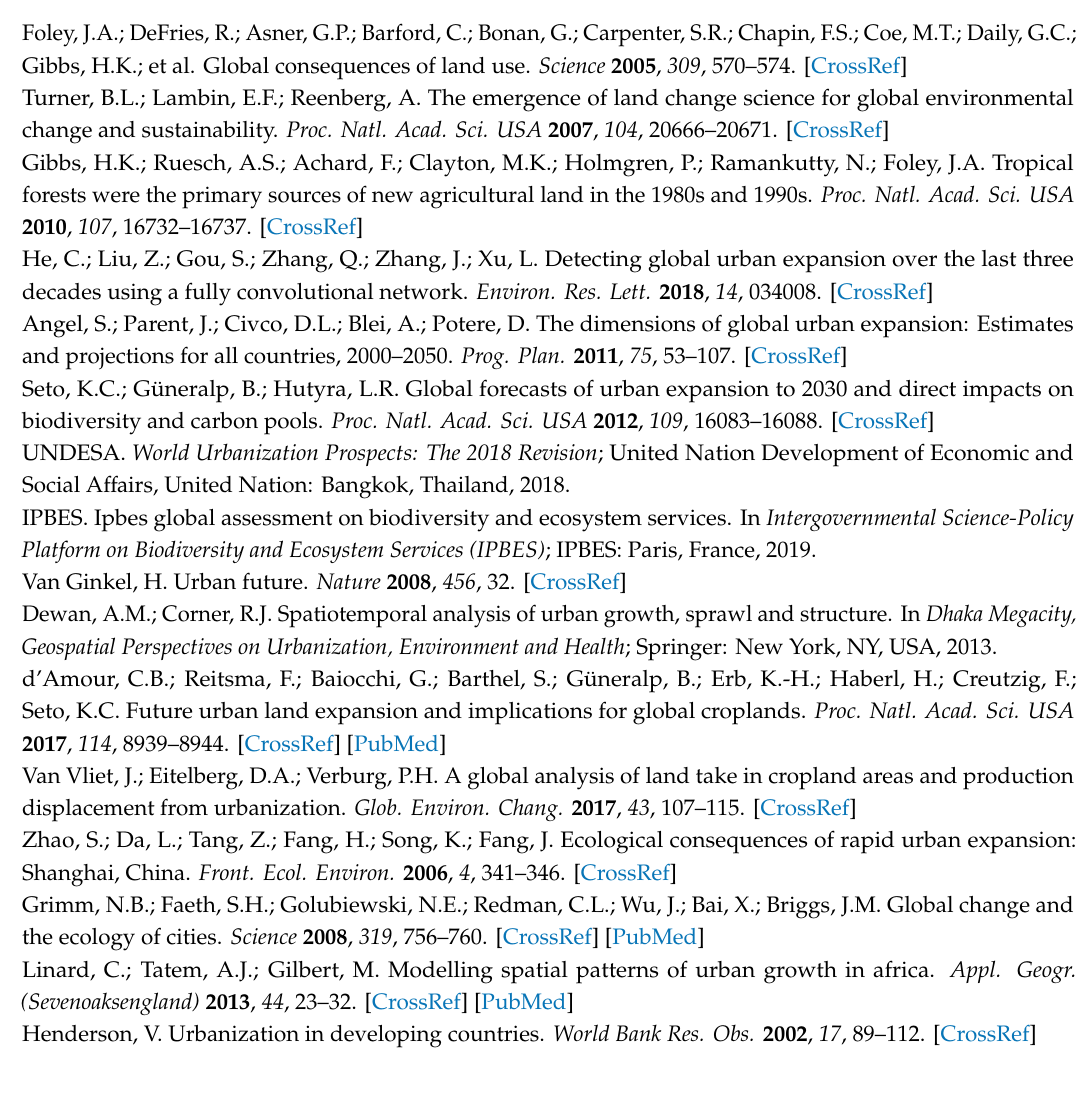
Table S1: Landsat Land-use / cover classification accuracies by district and year, Table S2: The absolute and relative areas of land-use / cover classes in western Tarai by year (km 2 ), Table S3. Land-use / cover class transition